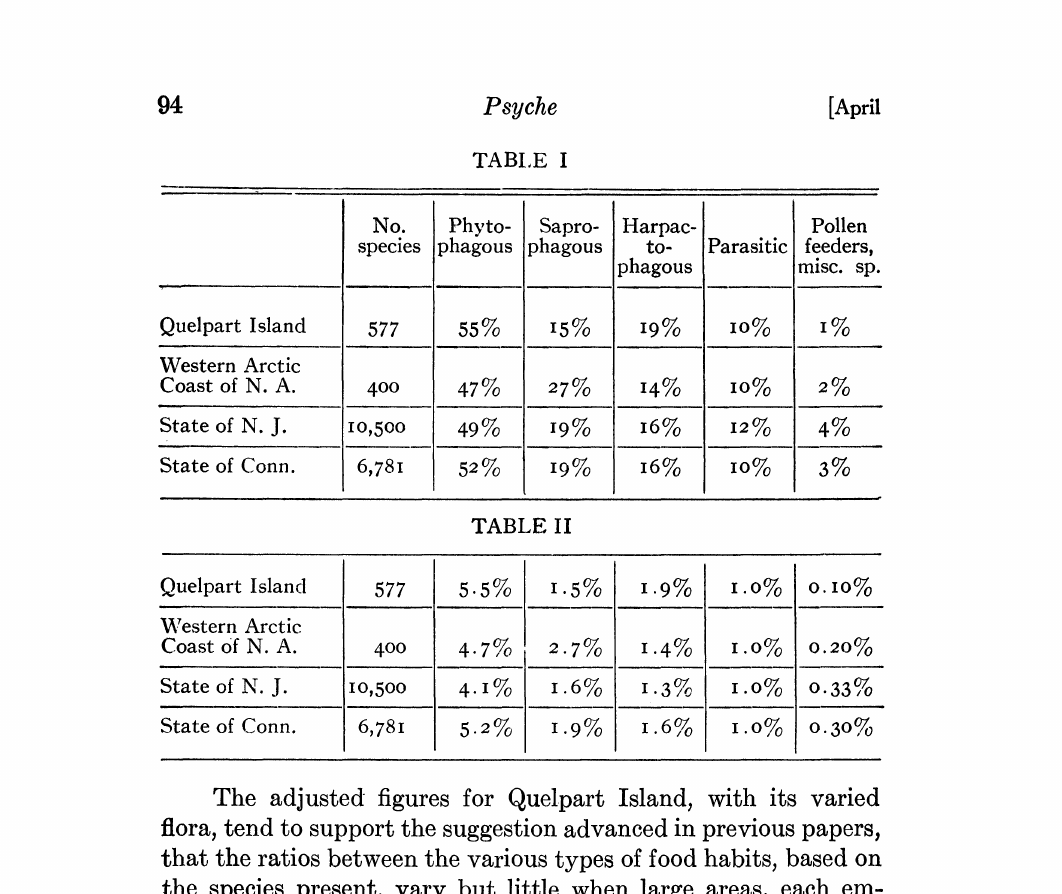
Pollen fe.eders, misc. sp.